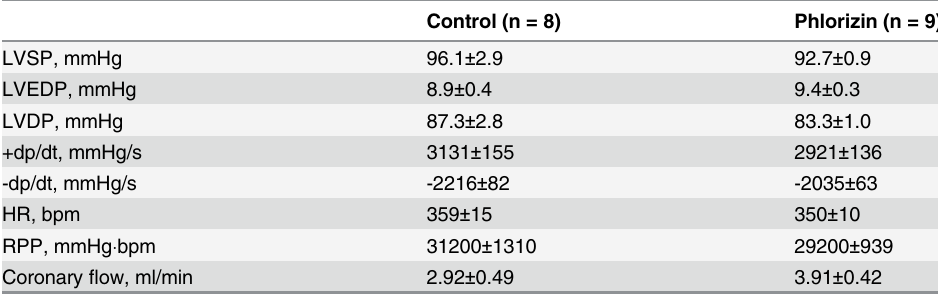
Table 2. Baseline cardiac function of ex vivo perfused